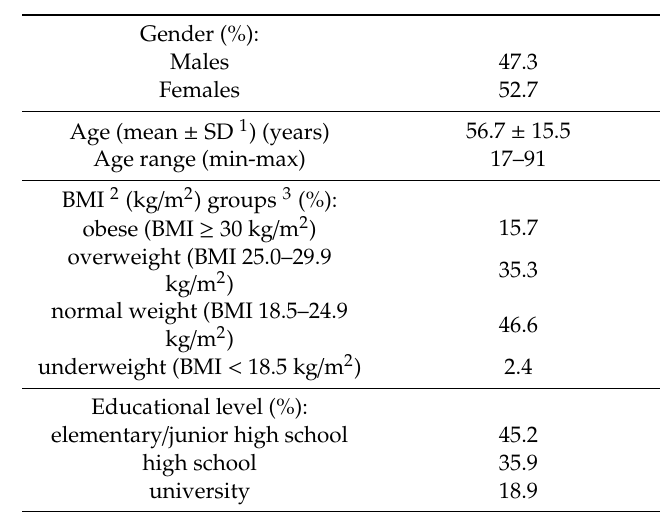
Table 1. Baseline descriptive characteristics of the investigated subjects ( n = 452).